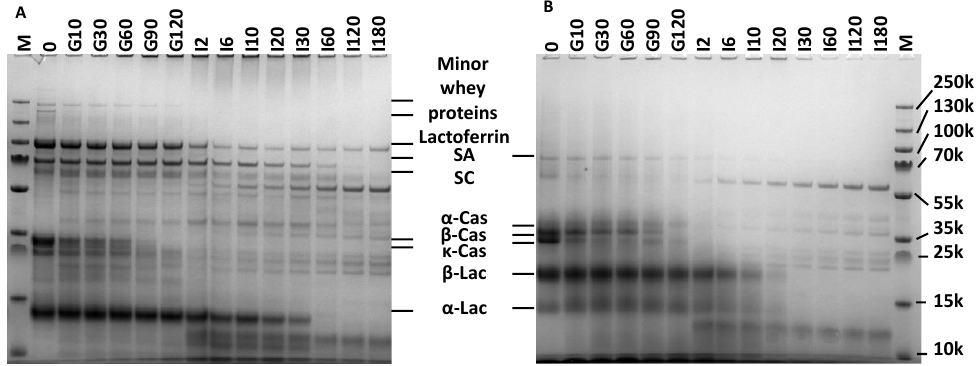
Figure 4. Typical SDS-PAGE gels loaded with undigested milk and digesta samples. ( A ) Human